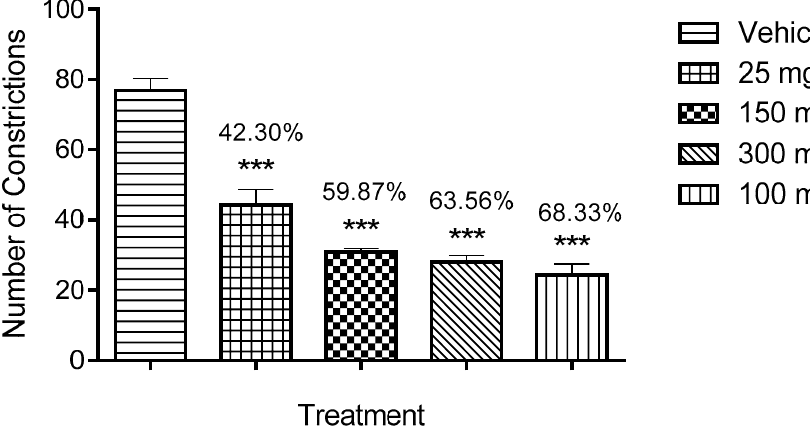
Figure 1. Effects of MEDL on acetic acid-induced abdominal constriction test in mice. Each column represents the mean ± SEM of six mice. Statistical analyses were performed using 1-way ANOVA followed by Tukey’s multiple comparisons test. *** p ≤ 0.001 compared to vehicle control group. Values on top of each column denote inhibition. Table 1. Effects of MEDL on the hot plate test in mice. Mice were treated with vehicle (10 mL/kg, p.o.),